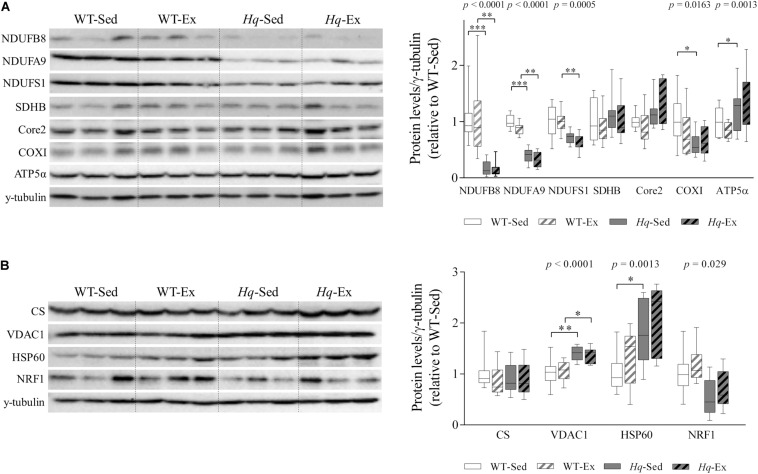
OXPHOS subunits and mitochondrial content. (A) Western blot analysis of representative OXPHOS components and (B) mitochondrial content markers in cerebellum homogenates of wild-type sedentary (WT-Sed, n = 12) and exercise-trained (WT-Ex, n = 11) mice, and of Hq sedentary (Hq-Sed, n = 11) and exercise-trained (Hq-Ex, n = 10) mice. Densitometry analysis: protein levels were normalized to γ-tubulin levels; data (median, interquartile range, and min and max values) are expressed relative to levels in the WT-Sed group. Significant p-values for group effect (Kruskal-Wallis test) are shown above the corresponding boxes. Symbols for significant differences in post hoc pairwise comparisons: ∗p < 0.05; ∗∗p < 0.01; ∗∗∗p < 0.001 for Hq-Sed vs. WT-Sed, and Hq-Ex vs.WT-Ex. ATP5α, ATP synthase subunit alpha; Core 2, ubiquinol-cytochrome C reductase core protein 2; COXI, cytochrome c oxidase subunit I; CS, citrate synthase; HSP60, heat shock protein 60; NDUFA9, NADH:ubiquinone oxidoreductase subunit A9; NDUFB8, NADH:ubiquinone oxidoreductase subunit B8; NDUFS1, NADH:ubiquinone oxidoreductase subunit S1; NRF1, nuclear respiratory factor 1; SDHB, succinate dehydrogenase complex iron sulfur subunit B; VDAC1, voltage-dependent anion-selective channel protein 1.